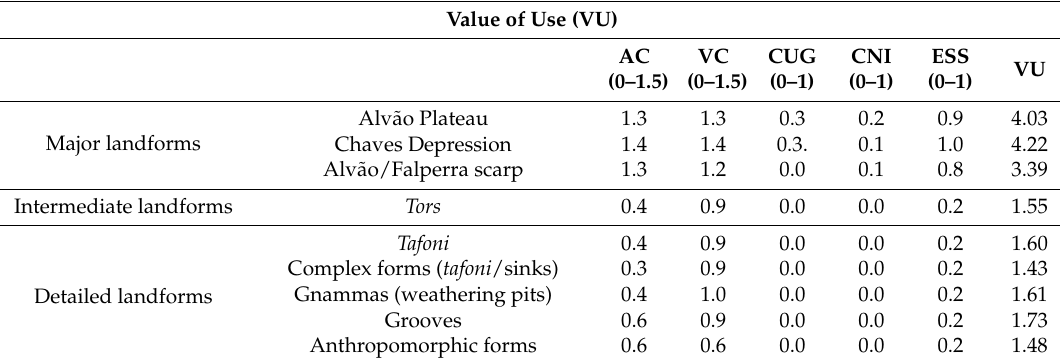
Table 3. Value of use (VU) of the